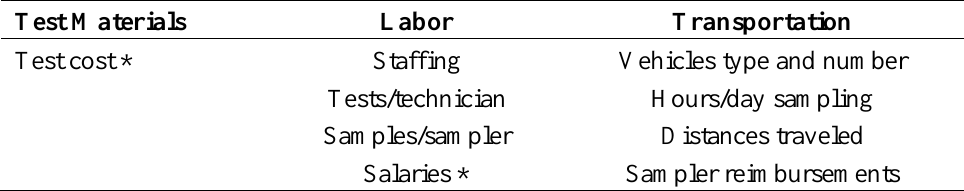
Table 3. Parameters used to calculate costs for each monitoring scenario.